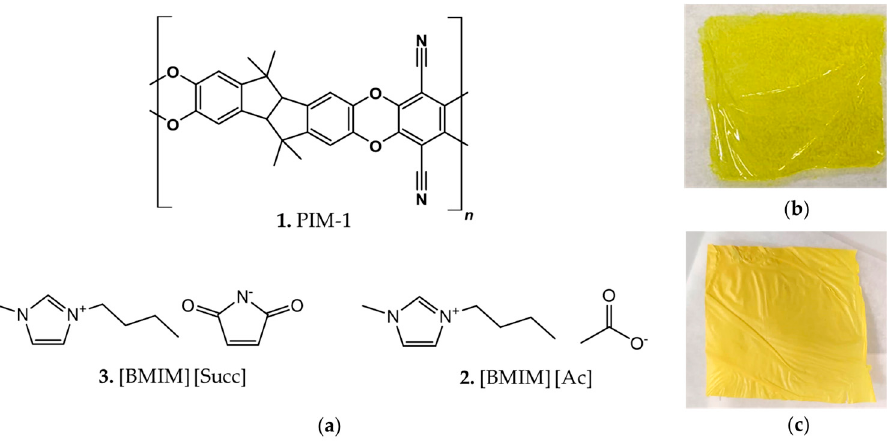
Figure 1. ( a ) Molecular structures of PIM-1( 1 ), 1-Butyl-3-methylimidazolium succinimidate [BMIM][Succ] ( 2 ) and 1 -Butyl-3-methylimidazolium acetate [BMIM][Ac] ( 3 ); ( b ) Self-standing PIM-1 membrane; ( c ) Self-standing PIM-1/[BMIM][Succ] 2/1 membrane.